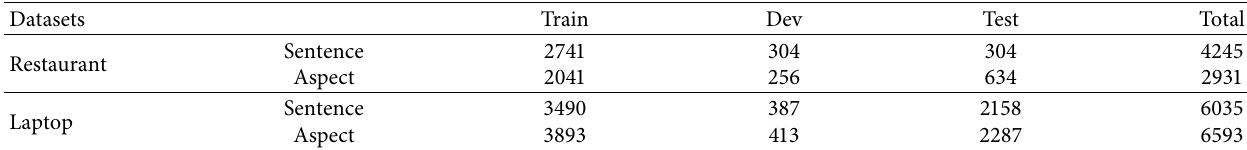
Table 1: Statistics of datasets.